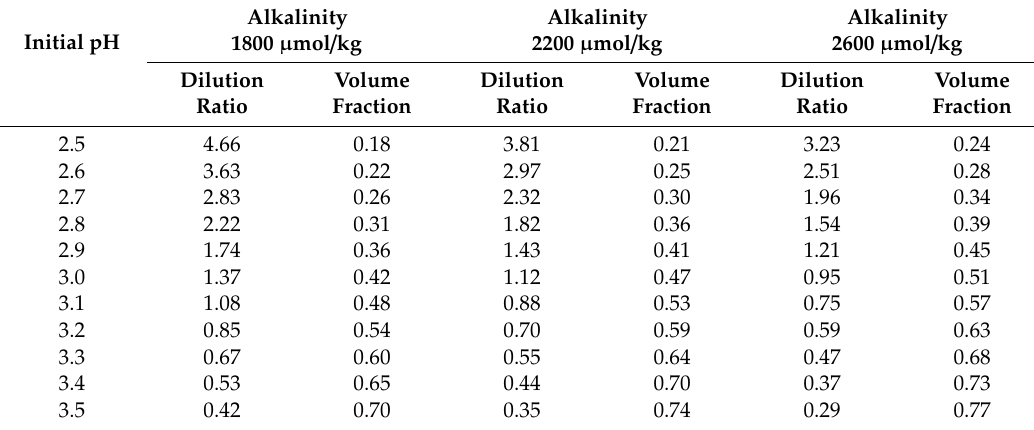
Table 1. Required dilution ratio and volume fraction depending on the initial pH of scrubber wash water under di ff erent seawater alkalinity